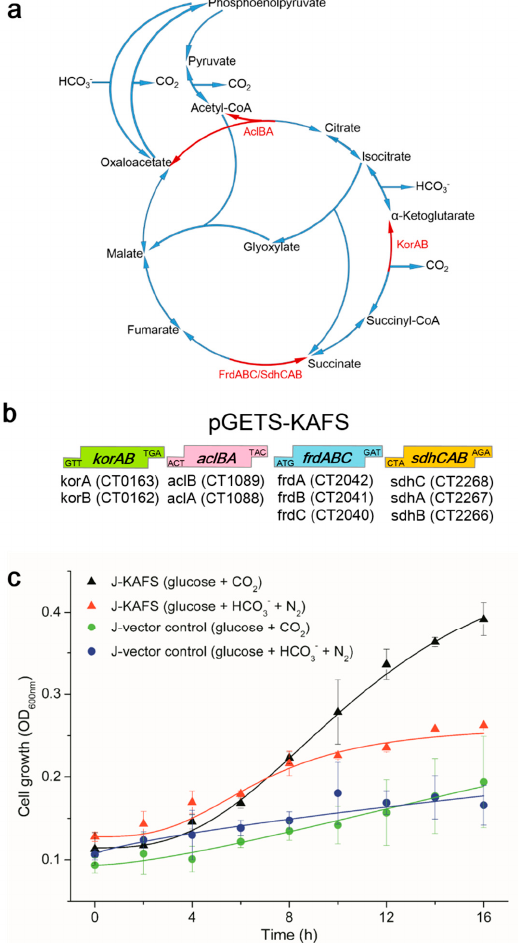
Figure 1. Designed genetic pathway and growth of transgenic E. coli strains with different inorganic carbon sources. ( a ) Pathway map of CO 2 assimilation enzymes related to this study. The heterologously expressed enzymes are marked in red. AclBA, ATP-dependent citrate lyase; KorAB, α -ketoglutarate:ferredoxin oxidoreductase; FrdABC/SdhCAB, fumarate reductase. Blue arrows represent TCA cycle activities contributed by E. coli genes; arrowheads indicate oxidative (clockwise) or reductive (counter-clockwise) activities; blue/red activity lines are oxidative direction only for E. coli enzymes or reversible for cloned C. tepidum enzymes. ( b ) DNA cassettes used to construct the expression plasmid pGETS-KAFS, which encodes the korAB , aclBA , frdABC , and sdhCAB genes from C. tepidum . ( c ) Anaerobic growth curves of transgenic E. coli strains with CO 2 or bicarbonate present in glucose culture medium. Data are expressed as the means ± standard deviations, n = 3 independent biological